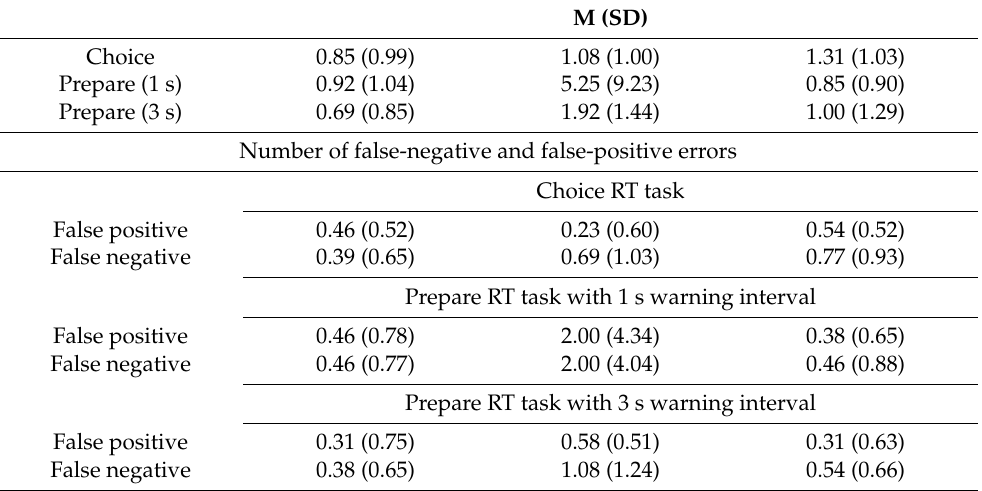
Table 5. Numbers of errors on all tasks across studied groups. PD-NC PD-MCI Comparison Group M